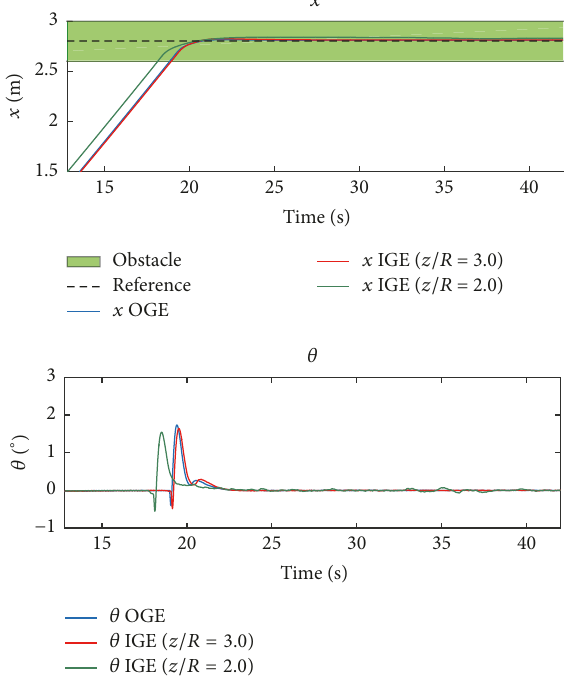
Figure21:Feedforwardcontroller:hoveringinpartialgroundeffect.